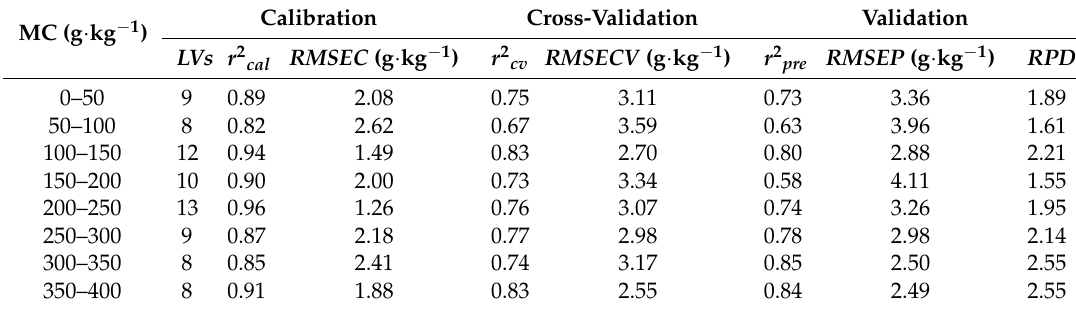
Table 2. Partial least squares regression (PLSR) model performance in predicting SOC content using visible and near-infrared reflectance (VIS-NIR) spectroscopy for eight levels of moisture content. The PLSR model was calibrated using Savisky-Golay smoothing